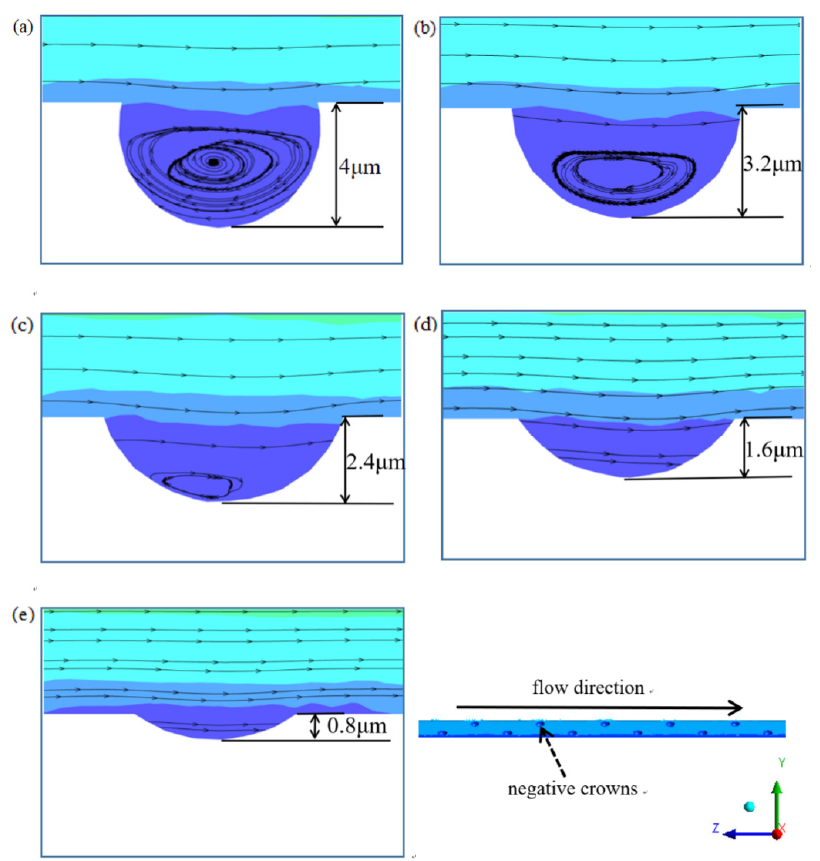
Figure 14. From ( a – e ) the longitudinal height of the negative crown is arranged in order from deep to shallow. It can be seen that as the longitudinal height decreases, the size of vortexes in the crown gradually decreases. Surface drag reduction.